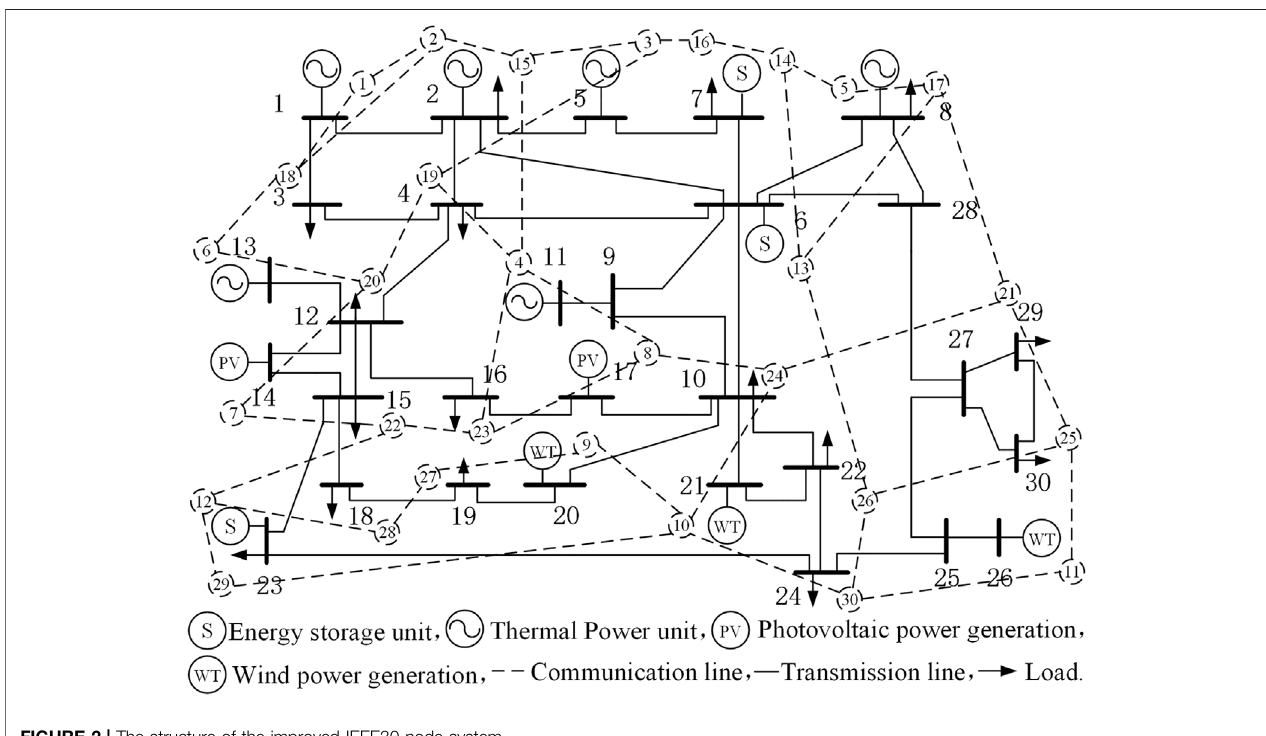
FIGURE 2 | The structure of the improved IEEE30 node system.